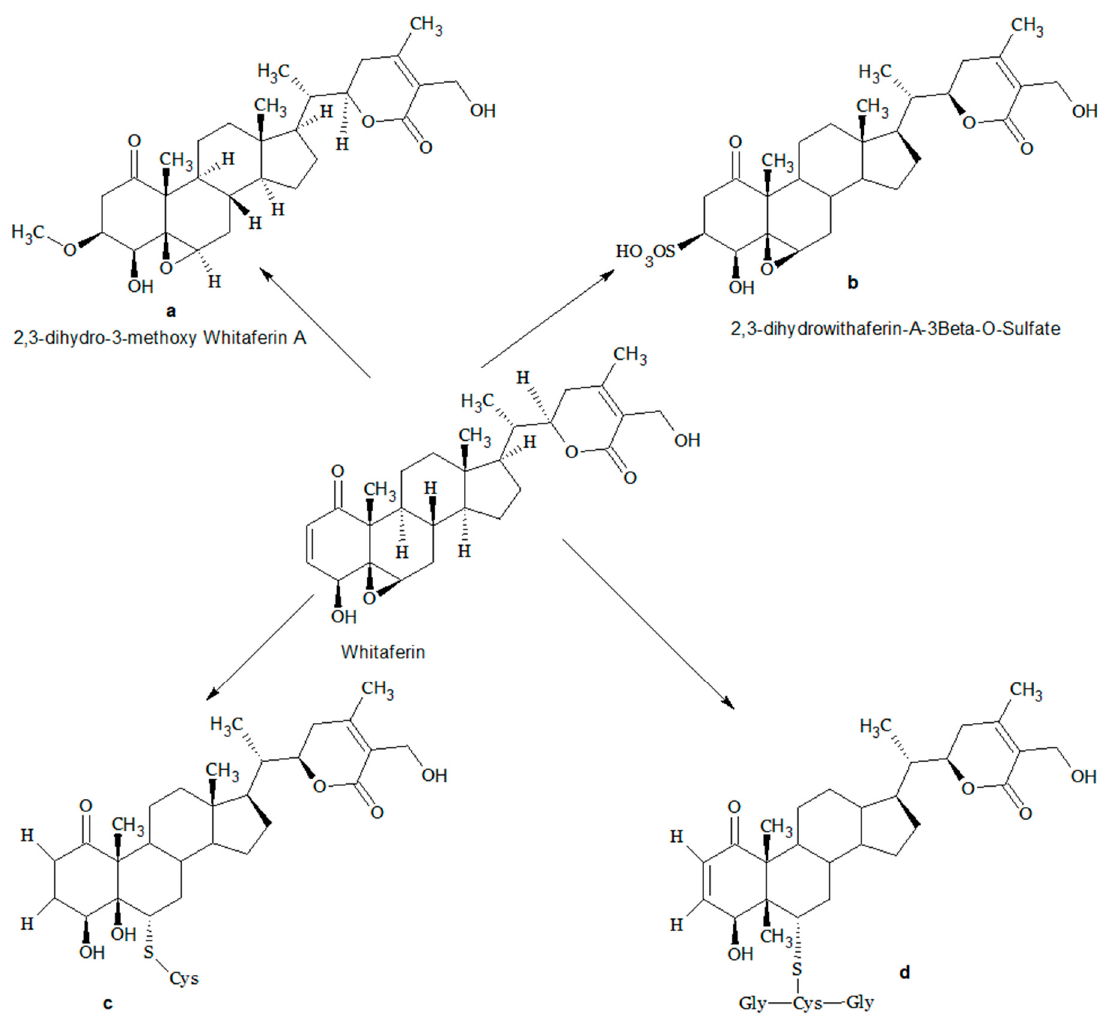
Figure 2. Metabolites of Withaferin A ( a ) 2,3-dihydro-3 β -methoxy Withaferin A; ( b ) 2,3-Dihydrowithaferin A-3 β -O-sulphate; ( c , d ) cysteine and glutathione conjugates of Withaferin A .